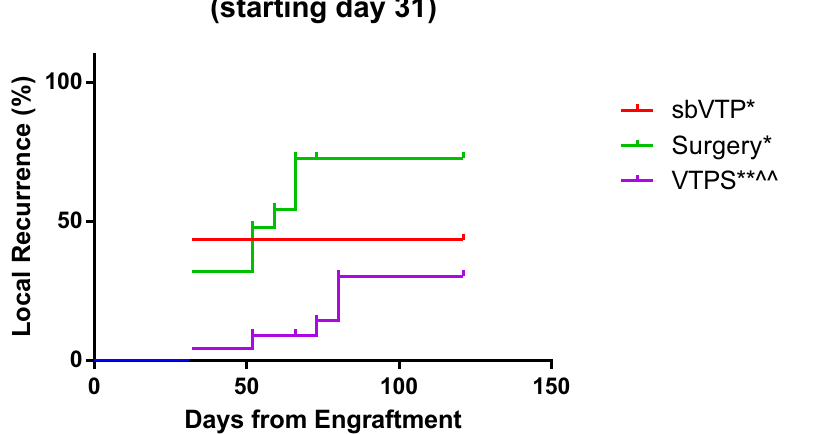
Figure 3. Kaplan–Meier analysis for local recurrence 121 days from tumor engraftment. Analysis started 31 days following tumor engraftment (day of tumor surgical resection for relevant groups). sbVTP sub-ablative vascular-targeted photodynamic therapy ( n = 23), VTPS sub-ablative vascular-targeted photodynamic therapy followed by surgical resection of tumor ( n = 22); Surgery ( n = 25). * P < 0.05 versus control; ** P < 0.01 versus control; ^^ P < 0.001 versus Surgery group. Control ( n = 5) animals were omitted from figure as no